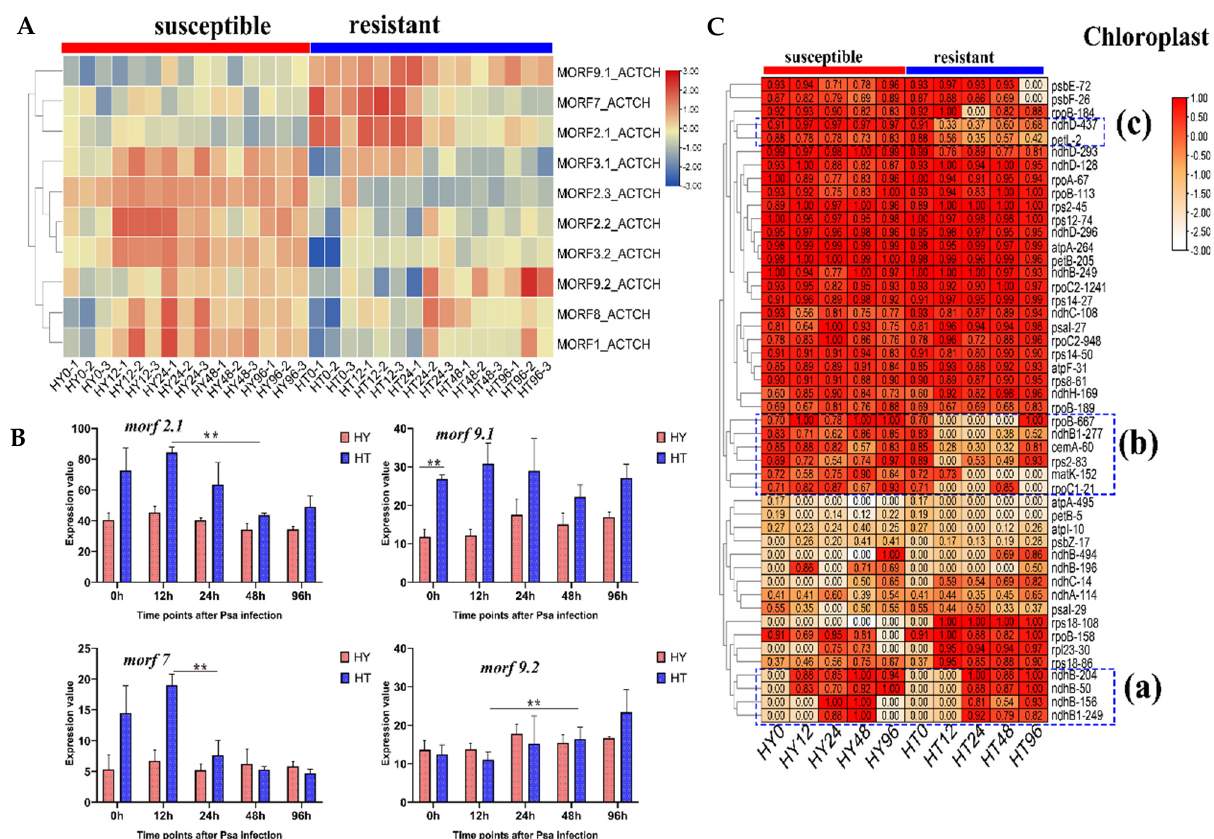
Figure 7. Expression and RNA editing pattern of MORF genes between resistant and susceptible kiwifruits in response to Psa infection. ( A ) Heat mapping of MORF gene expression between resistant and susceptible kiwifruits after Psa infection. The x-axis represents hours after Psa infection (0, 12, 24, 48, 96 hai), the y-axis represents MORF genes. The rows are clustered based on expression values. HY (‘Hongyang’) and HT (‘Huate’) represent susceptible and resistant kiwifruits, respectively. ( B ) Expression level of representative MORF genes ( MORF2.1 , MORF7 , MORF9.1 , and MORF9.2 ) between resistant and susceptible kiwifruits in response to Psa infection. Asterisks denote significant differences: * p -value < 0.05; ** p -value < 0.01. ( C ) Heat mapping of RNA editing efficiency in chloroplast genes between resistant and susceptible kiwifruits in response to Psa infection. The x-axis represents infection time points, the y-axis represents chloroplast RNA editing sites, and the rows are clustered based on RNA editing efficiency. Editing sites in response to infection are marked by a blue box.